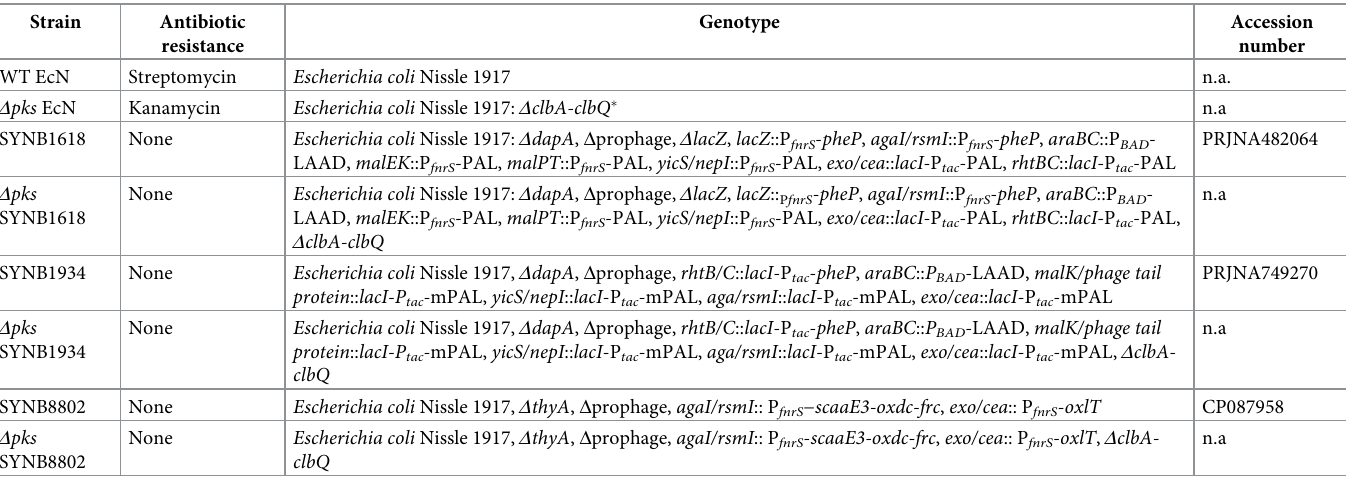
Table 1. Strains